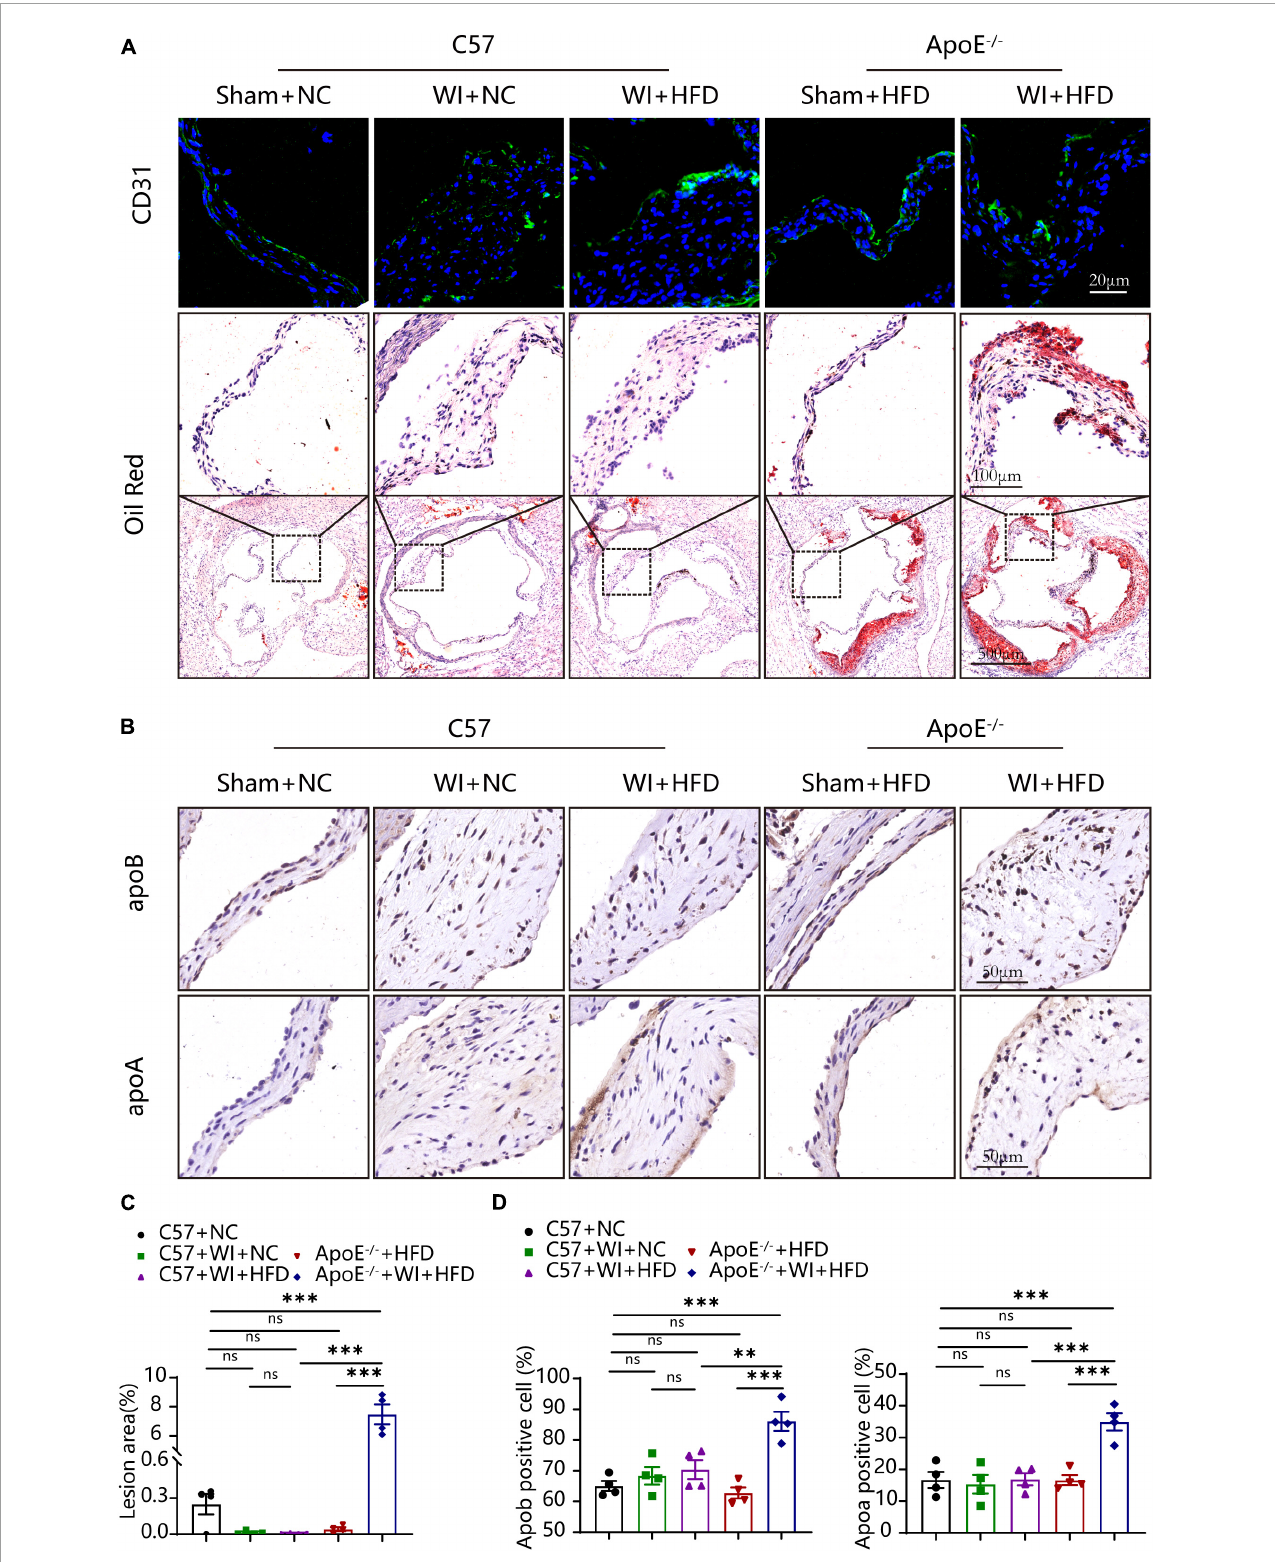
FIGURE4 Mechanical injury and hyperlipidemia induced advanced fatty and lipoproteins deposition beneath the leaflets endothelial. (A) Representative CD31 immunostaining (green, scale bar, 20 µ m) and Oil red O staining (top, scale bar, 100 µ m; bottom, scale bar, 500 µ m) of aortic valves 8 weeks after wire injury. Valvular lipid deposition was only observed in hypercholesterolemic mice 8 weeks after wire injury. (B) Representative images of apoB (scale bar, 50 µ m) and apoA (scale bar, 50 µ m) lipoproteins in the valvular 8 weeks after wire injury in the indicated groups ( n = 4 per group). (C) Quantification of the valvular lesion area (%) 8 weeks after wire injury in the indicated groups ( n = 4 per group). (D) Quantification of apoB (scale bar, 50 µ m) and apoA (scale bar, 50 µ m) lipoproteins in the valvular 8 weeks after wire injury in the indicated groups ( n = 4 per group). Results are mean ± SEM. Adjusted P values were provided in case of multiple groups. ns. indicates non-significant P value. ** P < 0.01 and *** P <